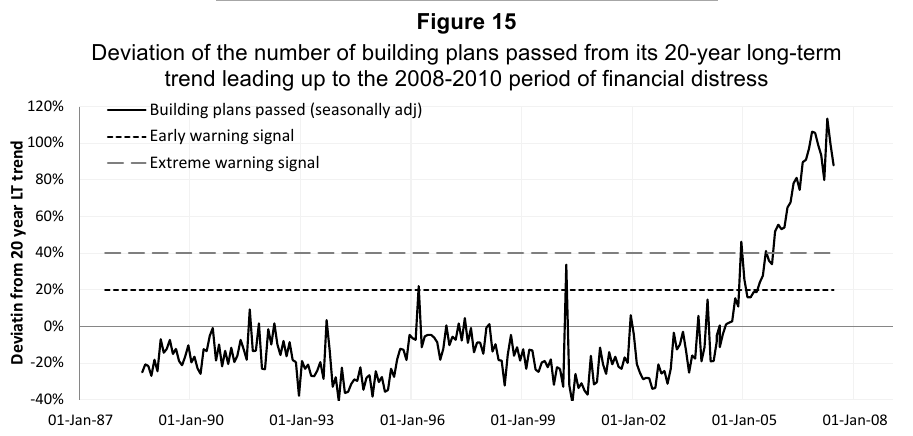
Deviation of the number of building plans passed from its 20-year long-term trend leading up to the 2008-2010 period of financial